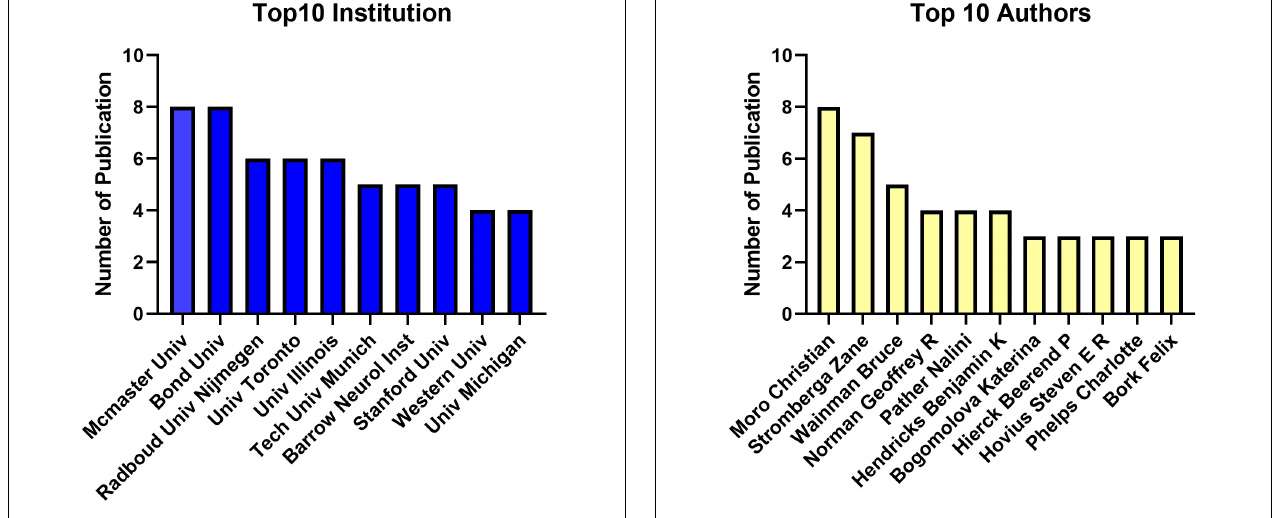
FIGURE 8 | The contribution of the top 10 institutions.